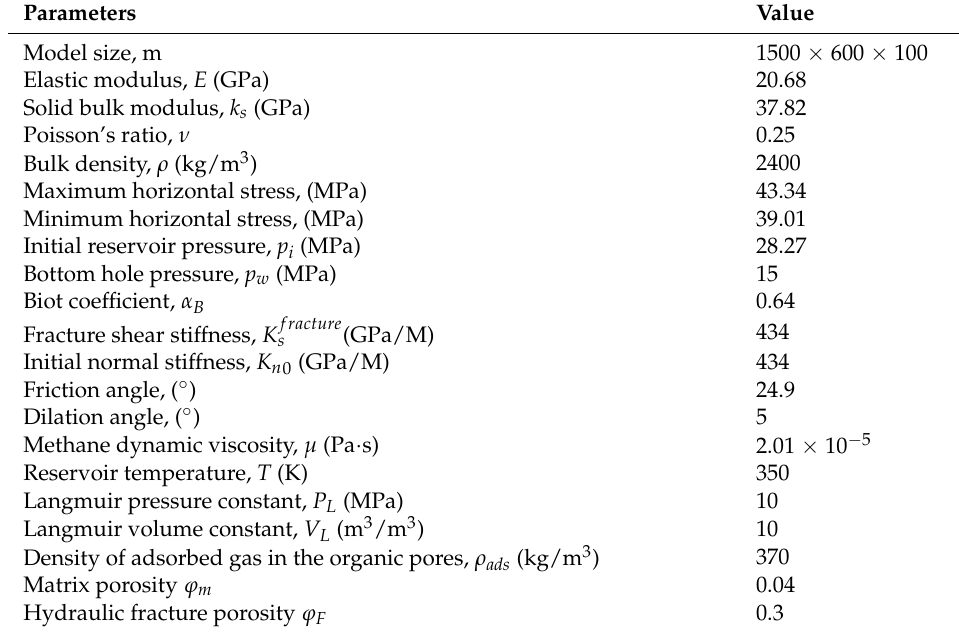
Table 3. Computational parameters used in